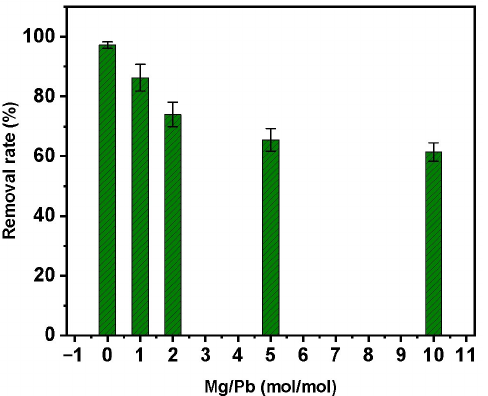
Figure 12. Pb 2+ removal rate at different concentrations of Mg 2+ . (Experimental conditions: pH = 6, MnO 2 /Mxene composite films 12 mg, solution volume 100 mL, C Pb 2 + = 30 mg/L, 25 ◦ C).